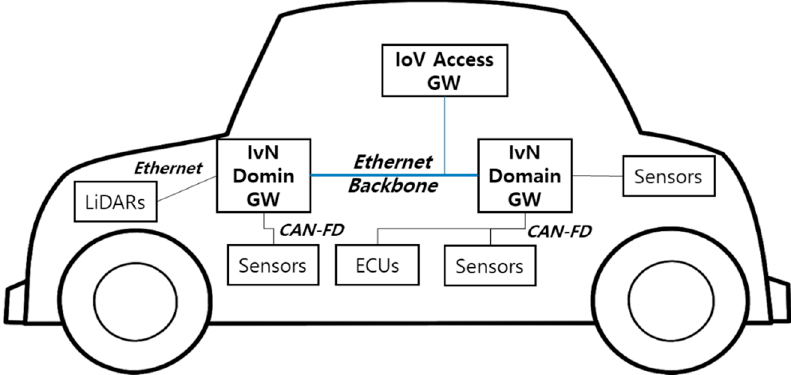
Figure 1. In ‐ vehicle network architecture.